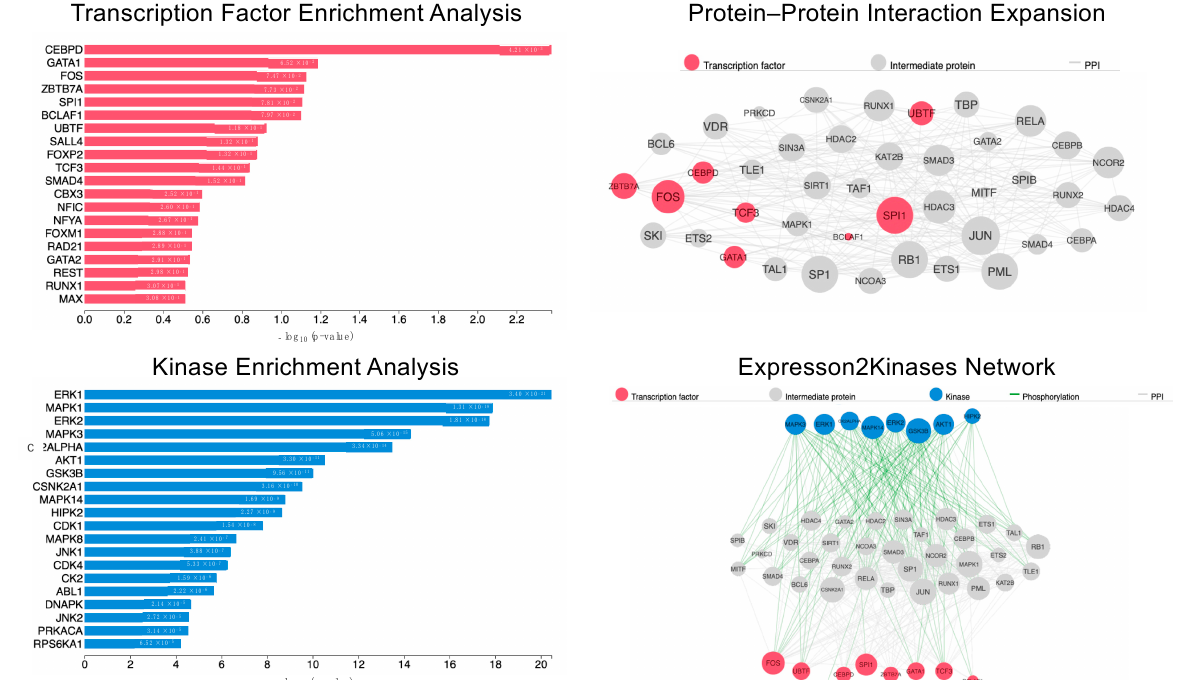
Figure 5. Proteomic analysis of liver samples. Upstream regulatory network of ( A ) upregulated and ( B ) downregulated protein signatures in liver samples from 2-week-old B6 and IARS1V79L mice. Three liver samples each from both mice ( n = 3) were pooled for analysis. The X2K protein network analysis depicts transcription factors (TFs, red nodes), intermediate proteins (gray nodes), and kinases (blue nodes). Gray edges indicate protein–protein interactions (PPI), and green edges indicate kinase-driven phosphorylation events. Node sizes are relative to expression levels.